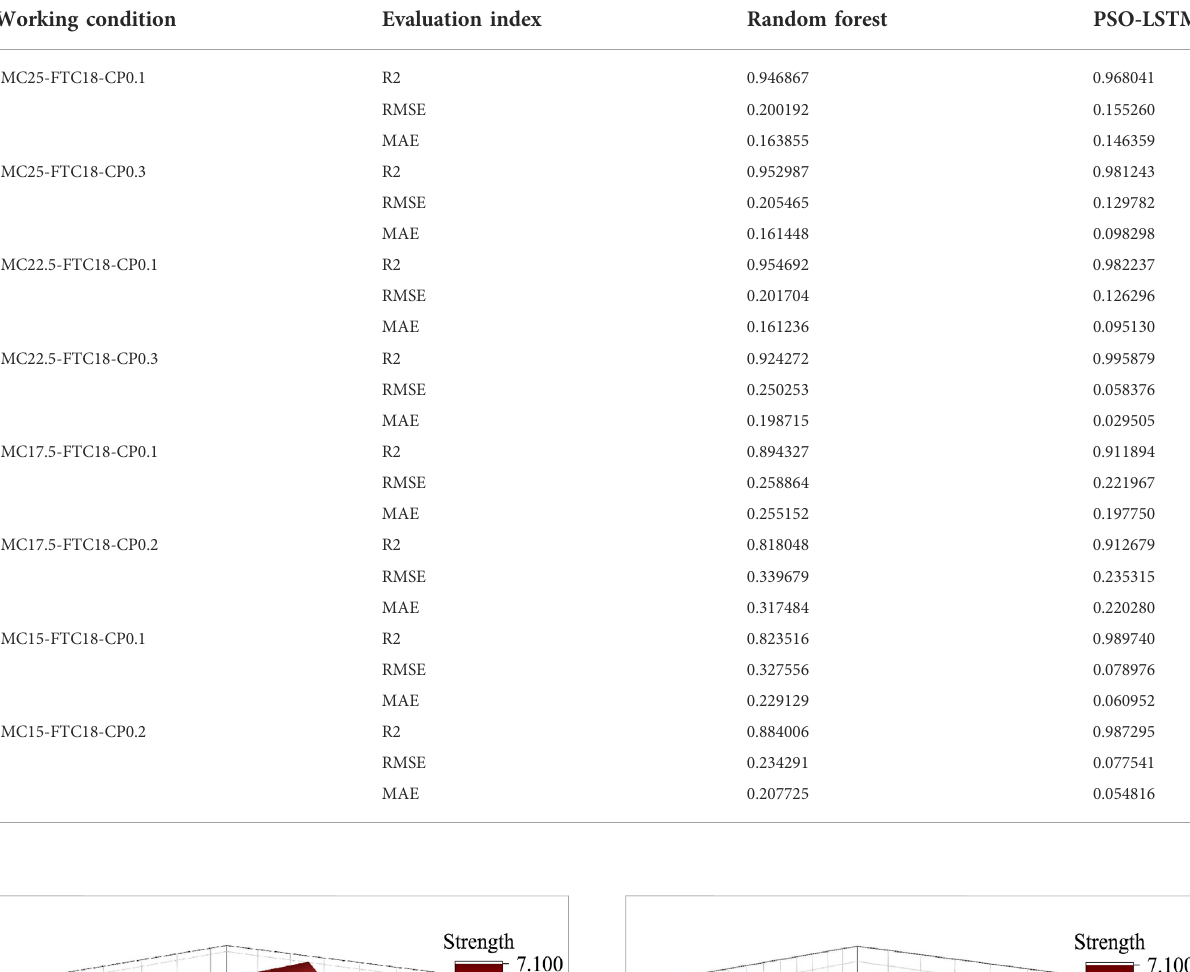
TABLE 6 Evaluation indicators of RF and PSO-LSTM model prediction and real